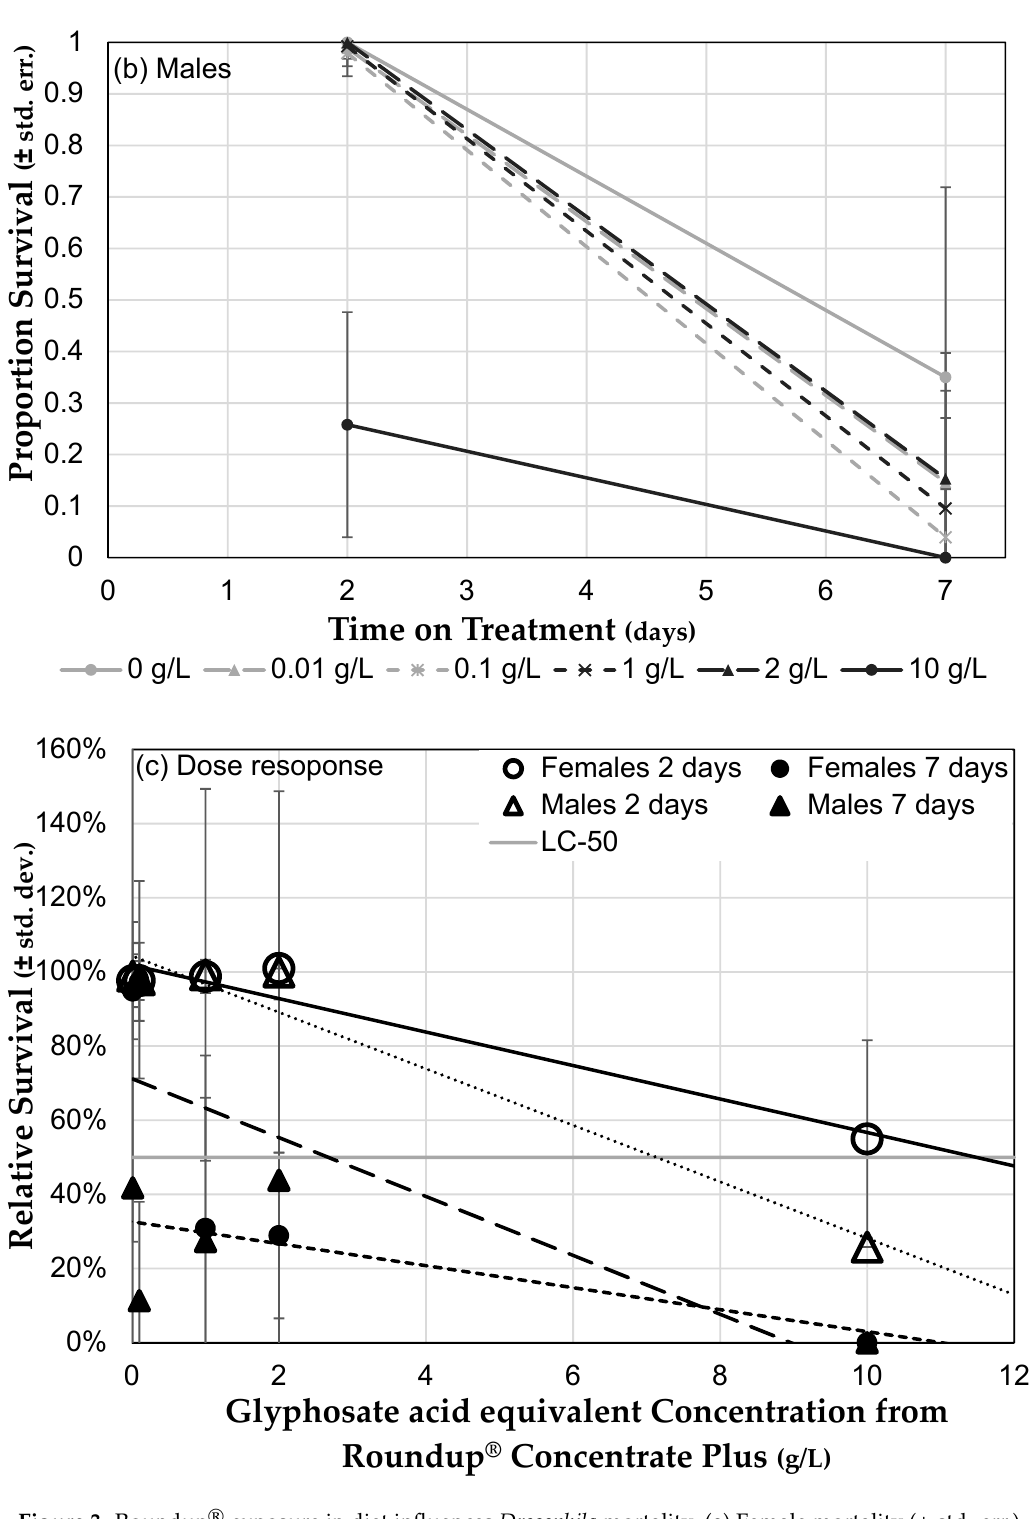
Figure 3. Roundup ® exposure in diet influences Drosophila mortality. ( a ) Female mortality (± std. err.) after two days and seven days of Roundup ® exposure (nine days and 14 days post eclosion) at six concentrations. ( b ) Male mortality (± std. err.) after two days and seven days of Roundup ® exposure. ( c ) Survival of females and males after two days and seven days of Roundup ® exposure compared to the survival of flies exposed to control medium (± std. dev.). The light grey line indicates 50% survival and can be used to determine LC 50 for two-days of exposure.